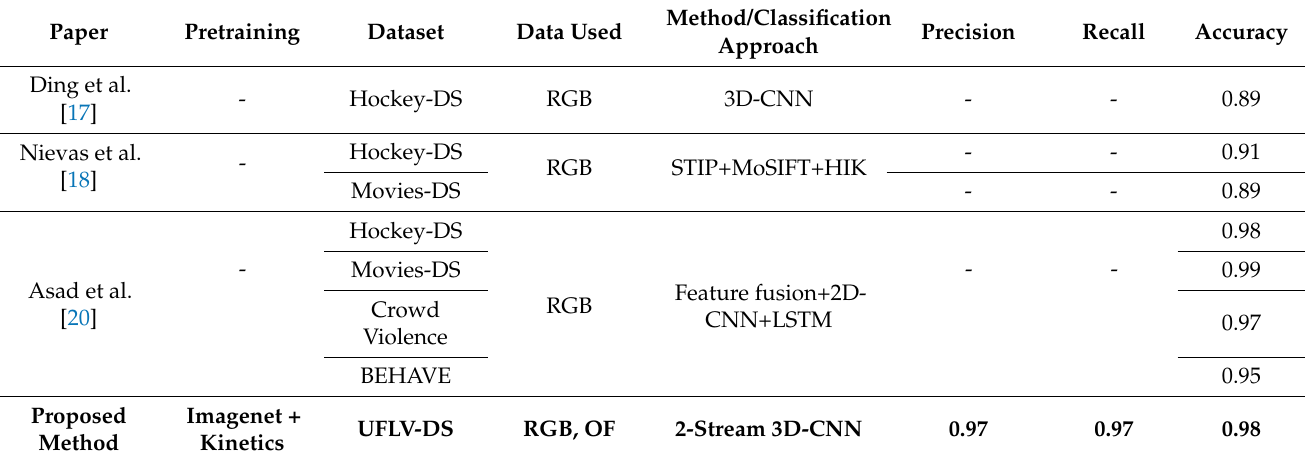
Table 10. Comparison with the state-of-the-art for